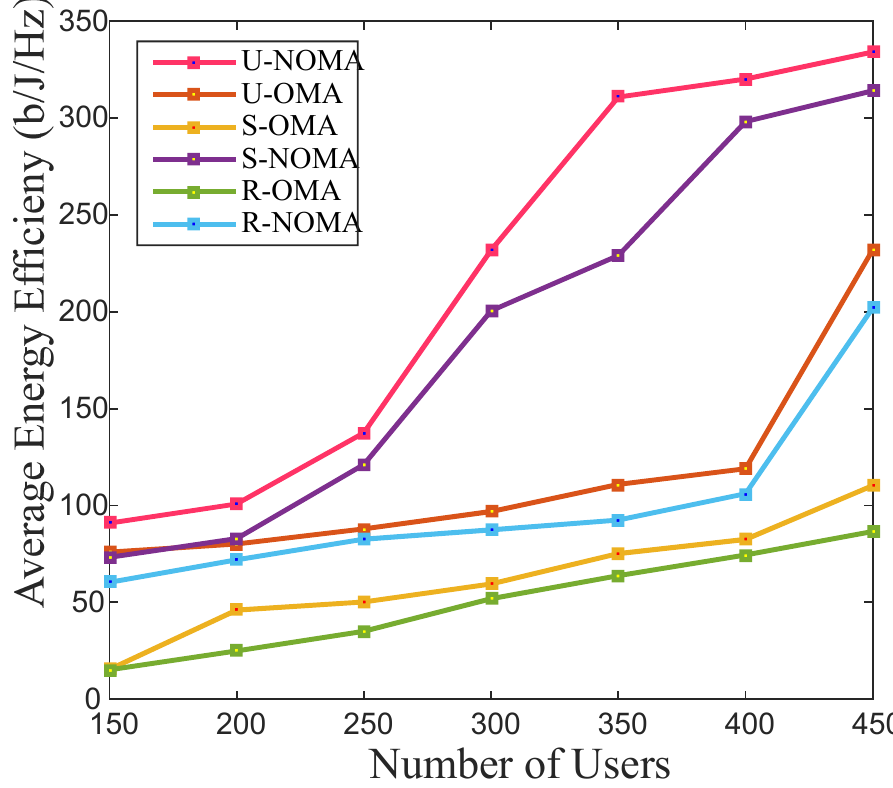
Figure 4. Average Energy Efficiency for a different number of total users in the cell.